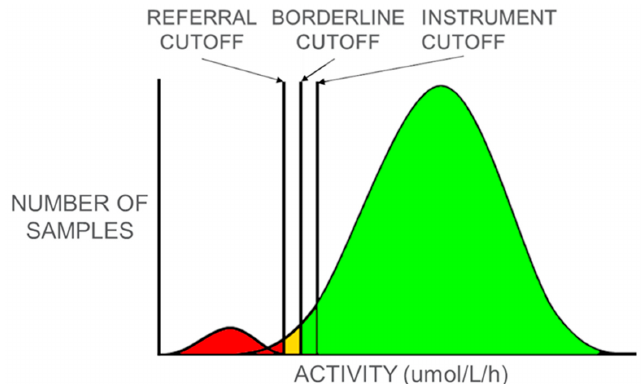
Figure 1. Representative depiction of the distribution of acid alpha-glucosidase (GAA) enzyme activity (low to high) in newborns. The small population to the left of the referral cutoff (depicted in red) indicates the high risk patient population that is referred for confirmatory testing. The large distribution to the right of the borderline cutoff (depicted in green) indicates the presumed normal population, who require no further action. As with many other newborn screening assays, there is an area of overlap between the affected and normal populations (indicated in yellow).